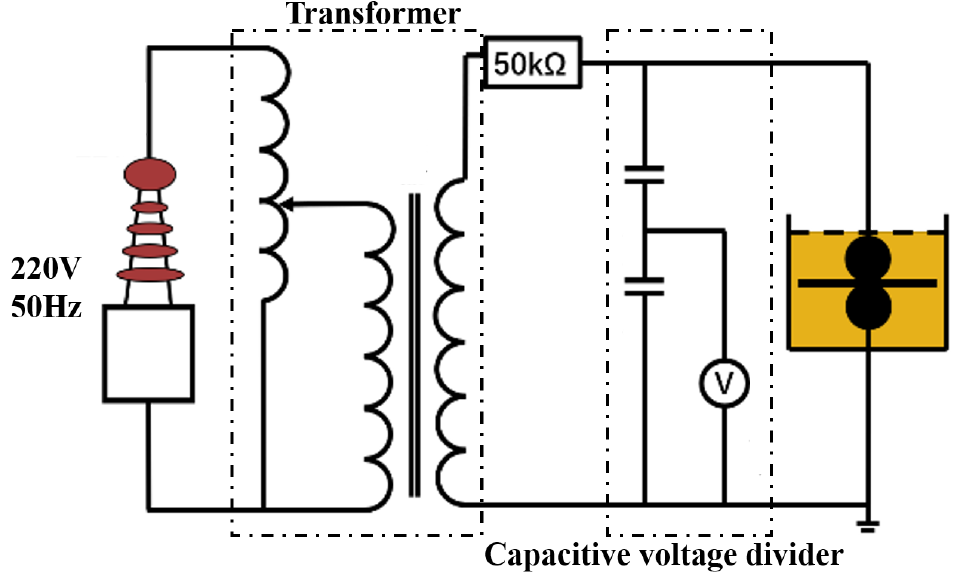
Figure 1. Breakdown strength test platform.